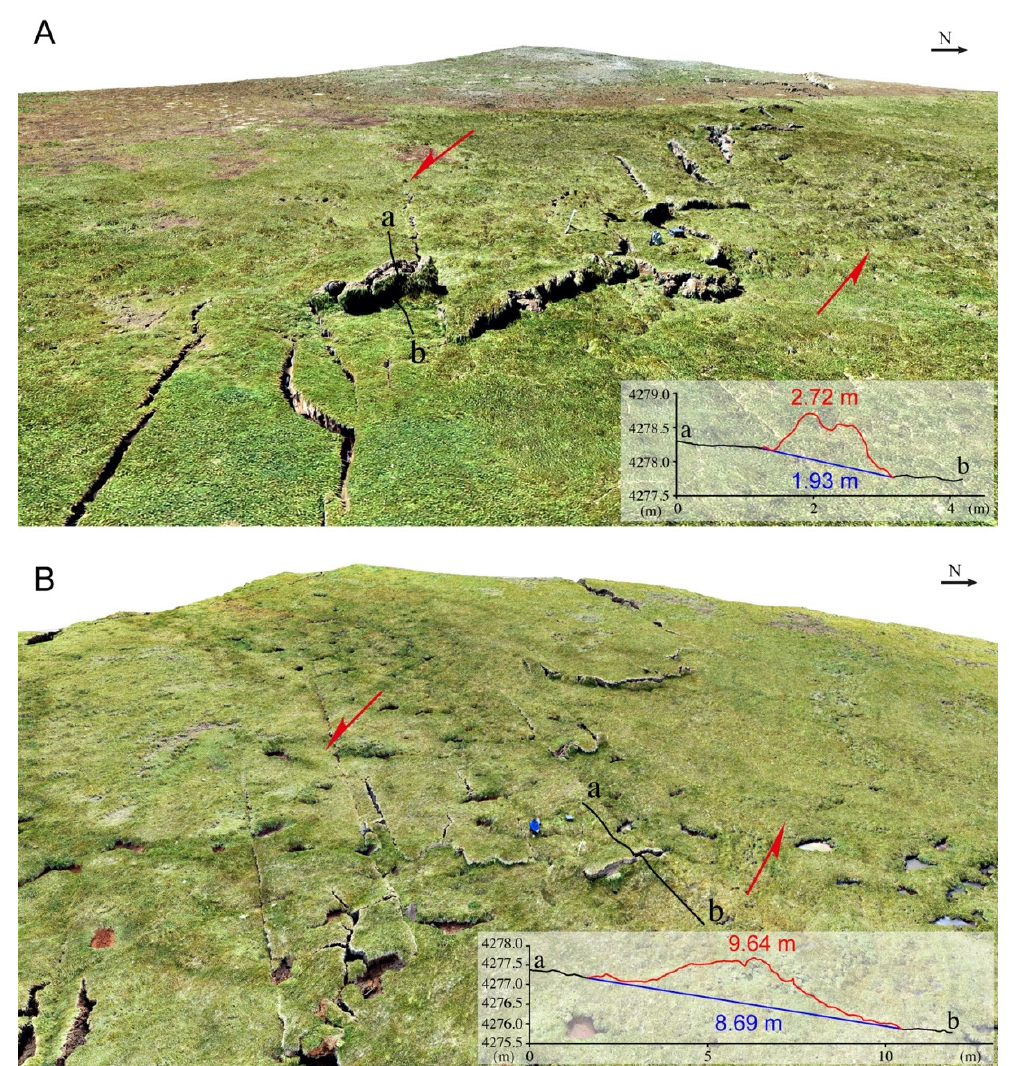
Figure 9. 3D visualization and measured profiles of push-up structures in the central-eastern section of the rupture with shortening values of ( A ) 0.79 m. θ is 52°, and the offset along the fault strike is 1.28 ± 0.2 m. and ( B ) 0.95 m. θ is 44°, and the offset along the fault strike is 1.32 ± 0.2 m.